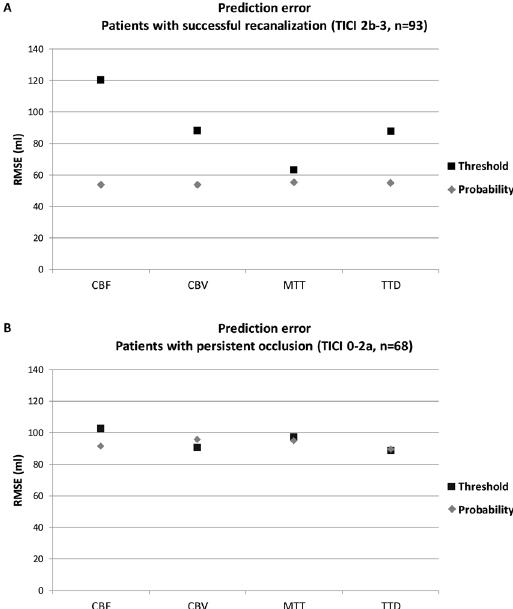
Figure 3. Root mean square error (RMSE) for ( A ) 93 patients with successful recanalization (TICI 2b-3) and ( B ) 68 patients with persistent occlusion (TICI 0-2a). The RMSE based on the CBF, CBV, MTT, and TTD maps using the conventional thresholding method and the probabilistic threshold-free method are shown. The prediction error is significantly lower for CBF, CBV, and TTD evaluated with the probabilistic threshold-free method compared to the threshold-based method in recanalized patients (p <